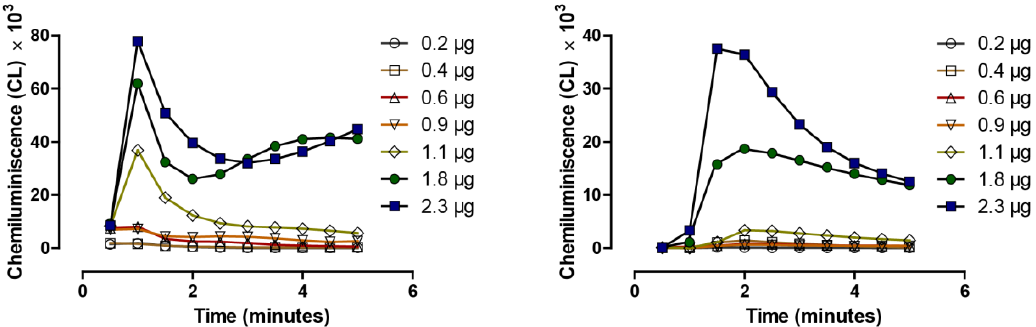
Figure 4. Quantitative analysis of generation of ROS, superoxide, by selenodiglutathione ( left